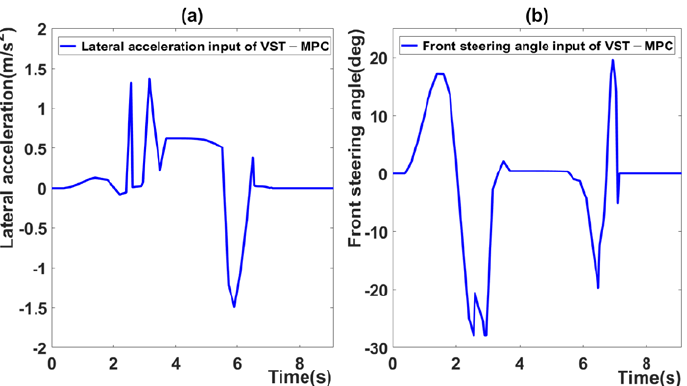
Figure 6. ( a ) Lateral acceleration input of VST-MPC, ( b ) steering angle input of VST-MPC.